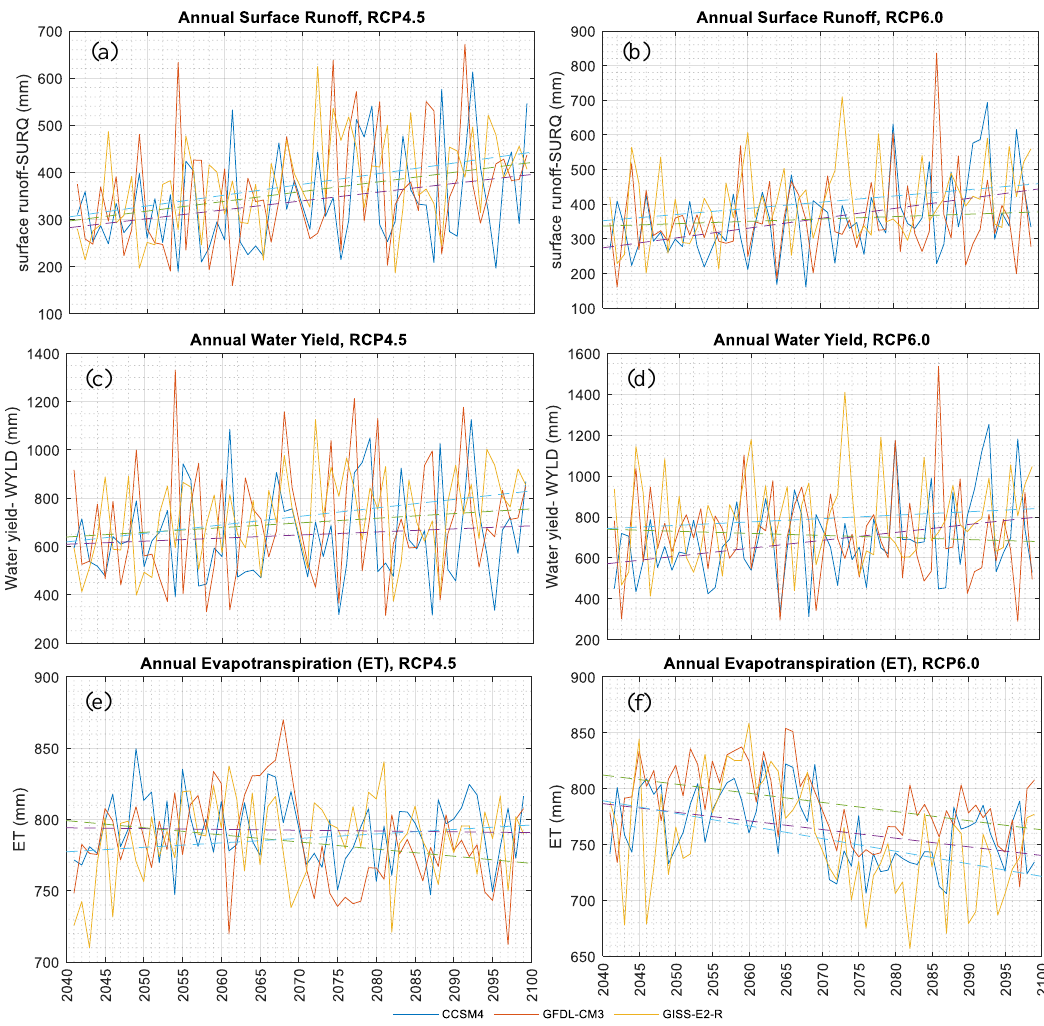
Figure 8. Average annual trend for hydrological components based on the three models under RCP4.5 and RCP6.0. The upper panel shows projected annual trend for surface runoff under RCP4.5 ( a ) and RCP6.0 ( b ). The middle panel presents projected annual trend for water yield under RCP4.5 ( c ) and RCP6.0 ( d ). The lower panel illustrates projected annual trend for ET under RCP4.5 ( e ) and RCP6.0 ( f ).